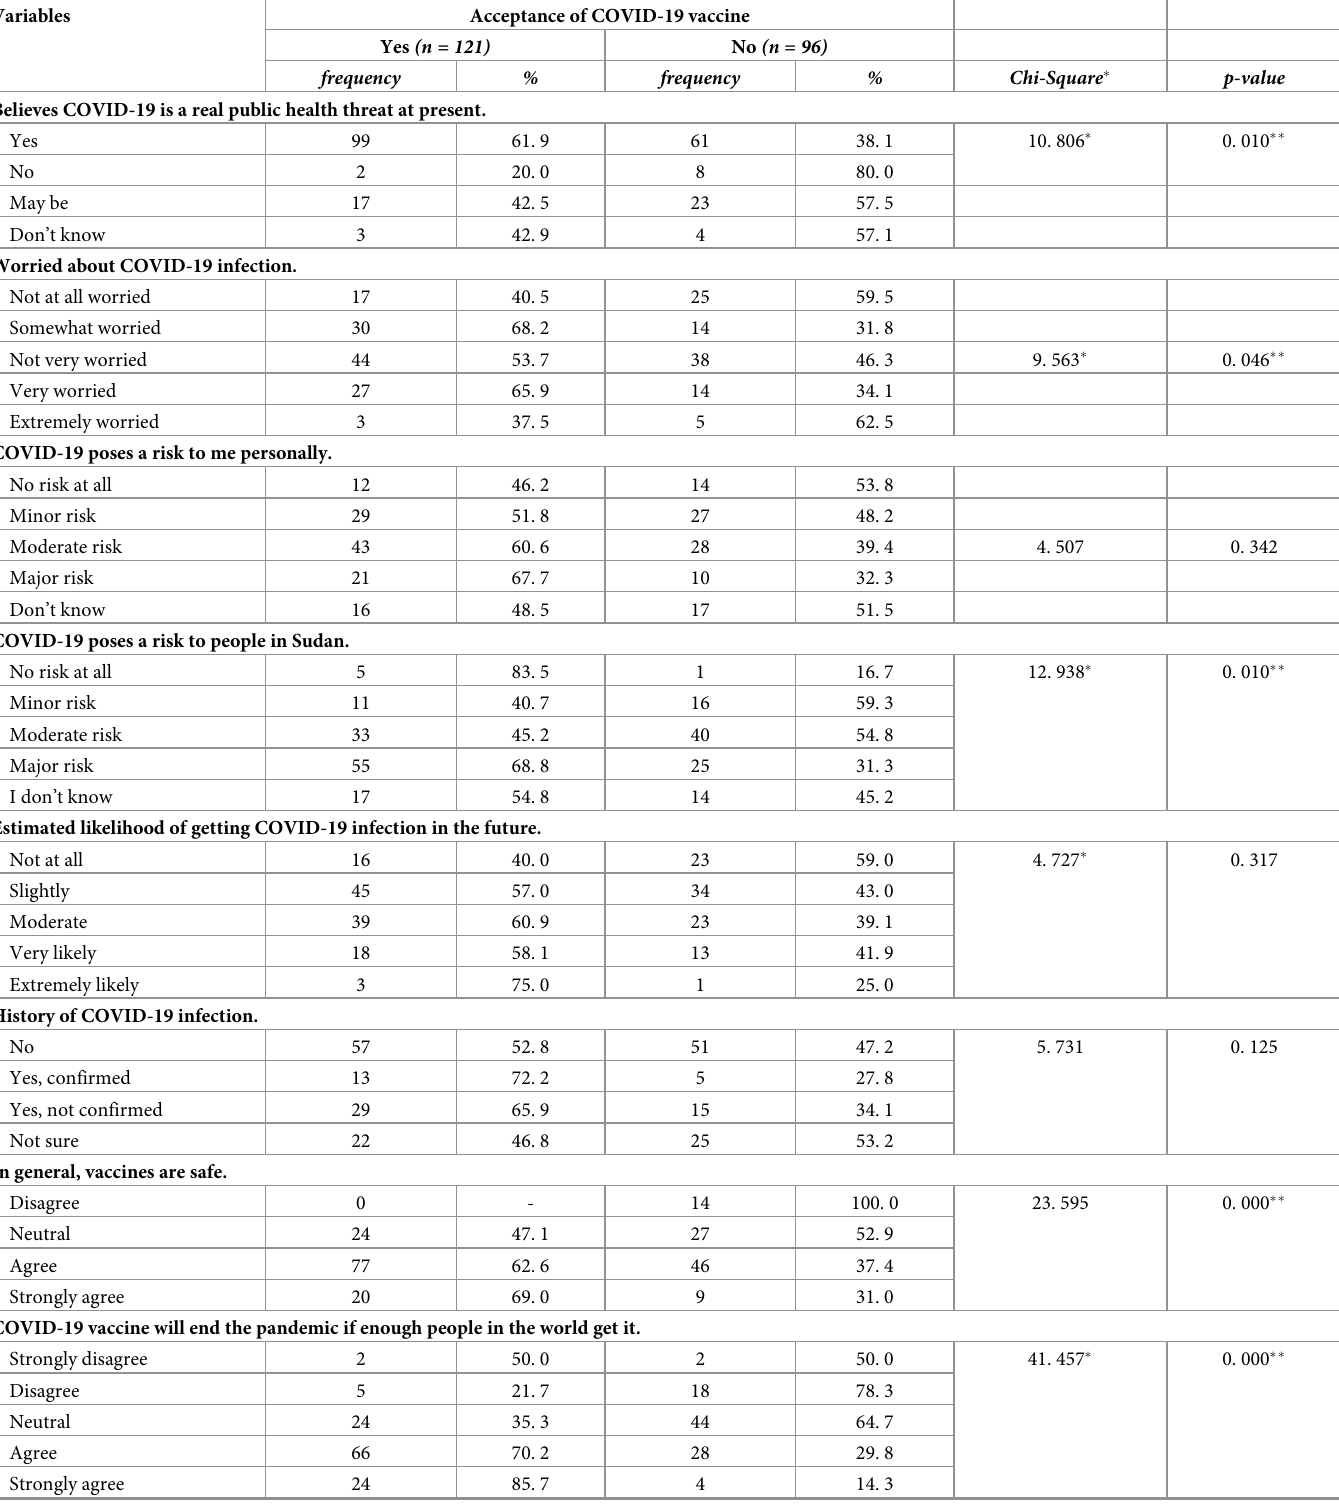
Table 4. Non-demographic factors associated with COVID-19 vaccine acceptance and hesitancy among medical students at IUA, Khartoum, Sudan, 2021 (n = 217). Variables Acceptance of COVID-19 vaccine Yes (n = 121) frequency % frequency Chi-Square